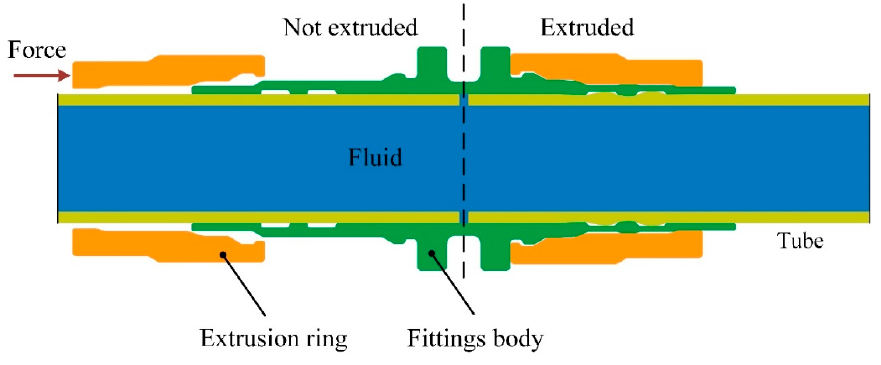
Figure 1. Axial extrusion-joint model.